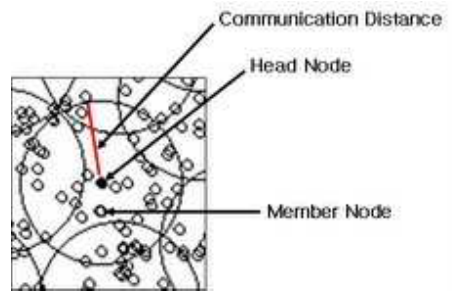
Figure 1. Clustering in a sensor network